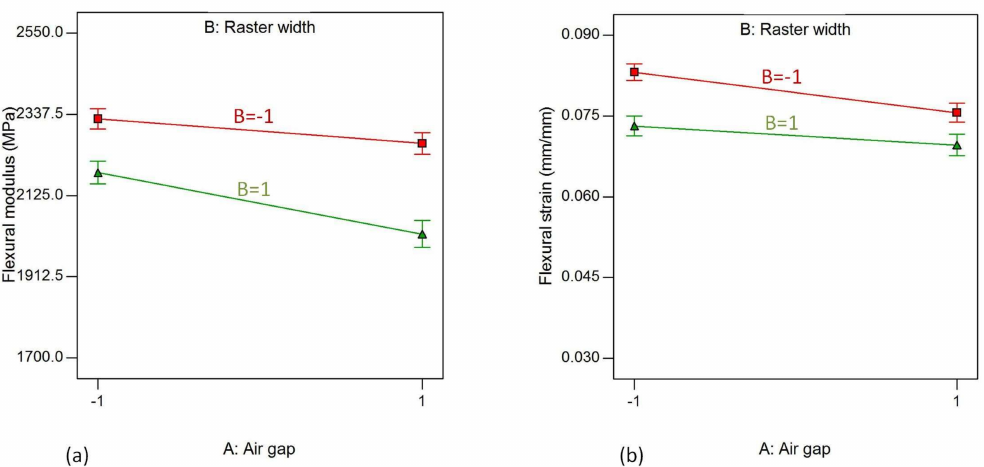
Figure 14. Interaction effect of air gap and raster angle on ( a ) flexural modulus and ( b ) flexural strain, while raster angle, cotour number and contour width are kept at their highest